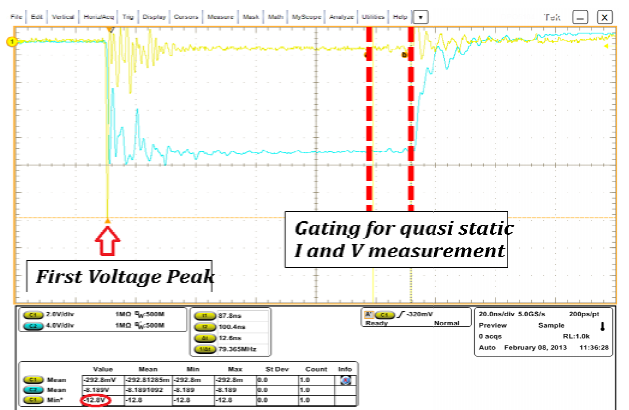
Figure 7: Measurement example. Increasing the TLP source amplitude progressively allows to build the global I/V characteristic, until the destruction of the device.